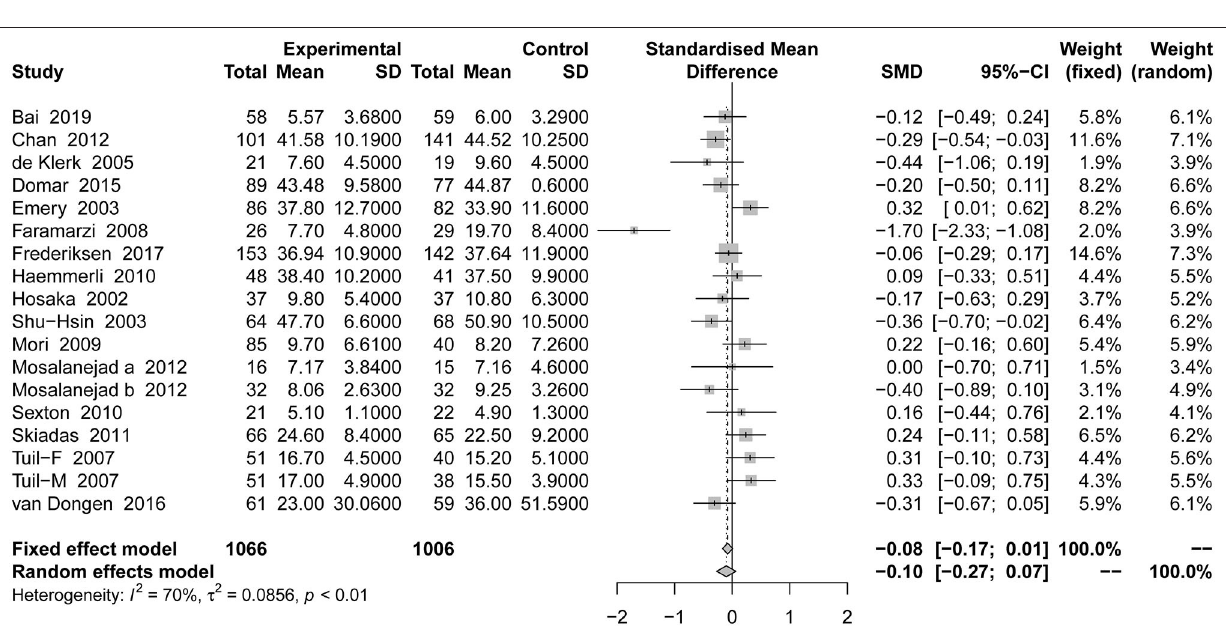
FIGURE 4 | Forest plot of anxiety in psychological